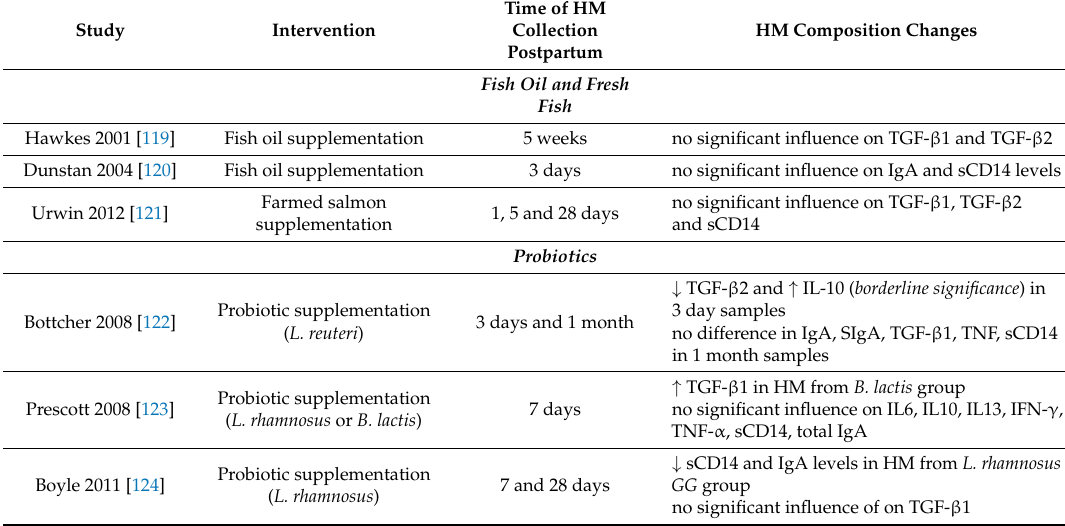
Table 1. Maternal dietary interventions and human milk immunological